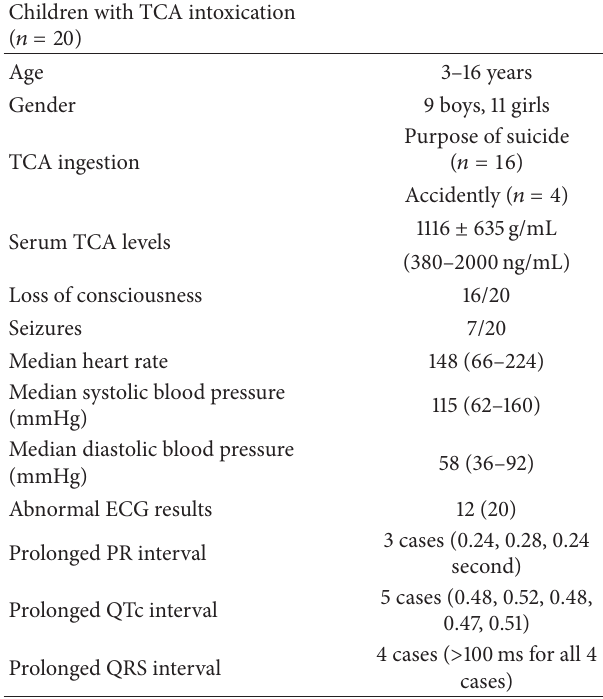
Table 1: Clinical and laboratory findings of children with TCA